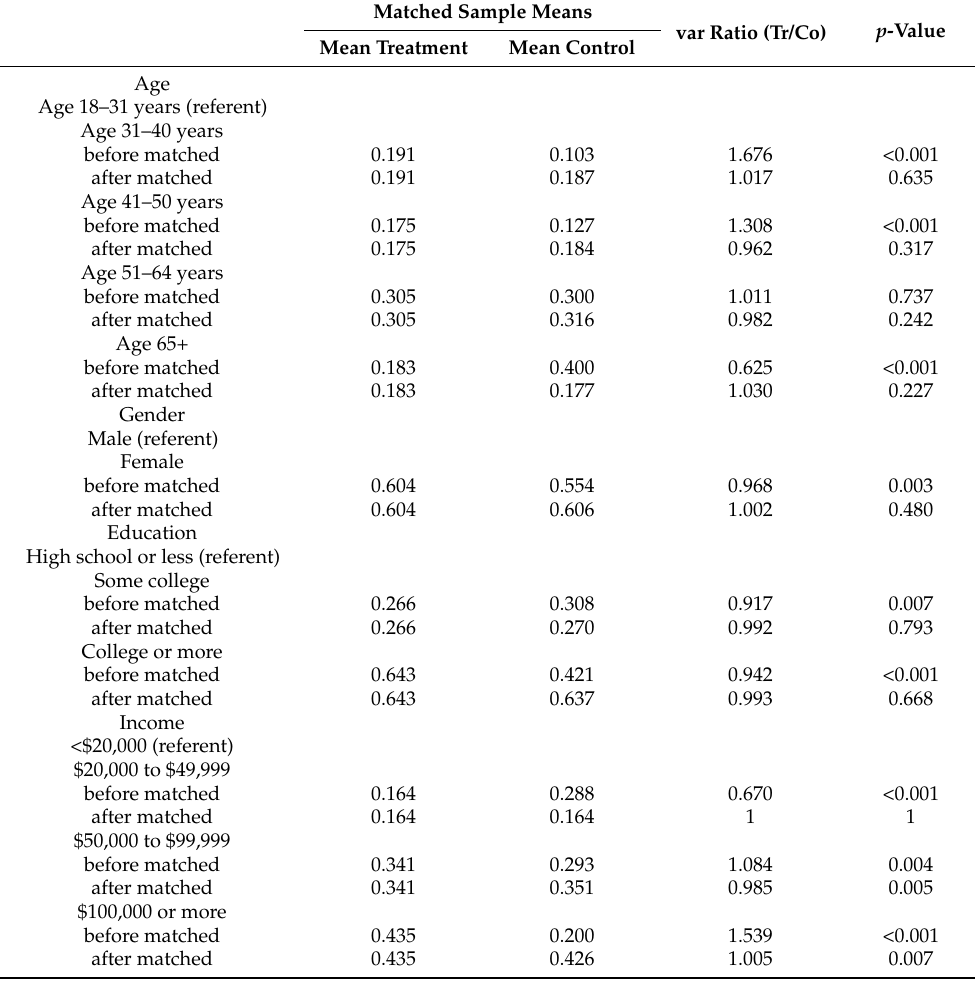
Table A2. The covariate balance of the effect of using wearable devices on the frequency of moderate intensity exercise for the whole